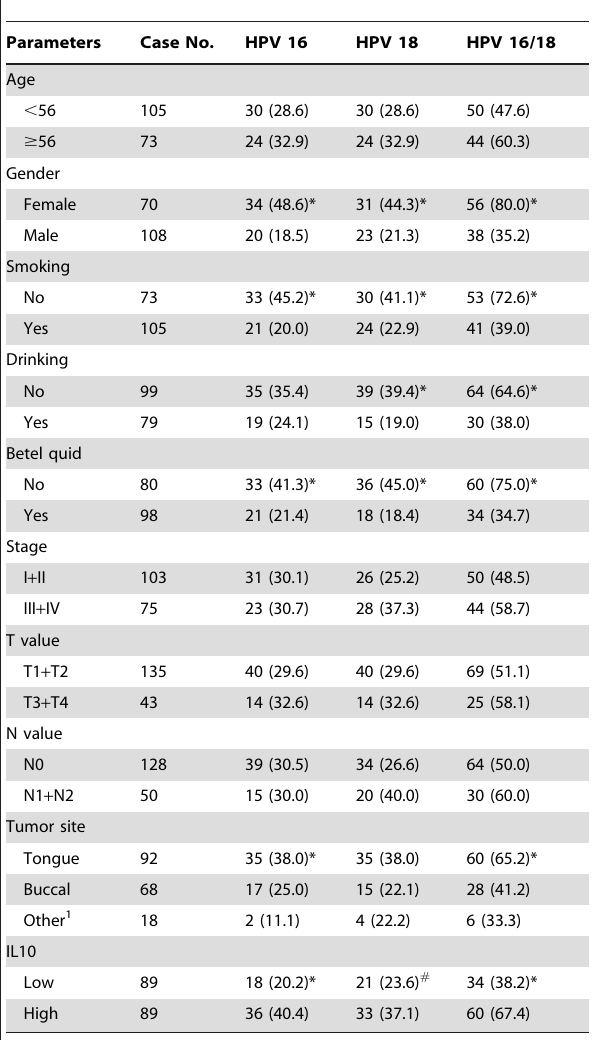
Table 1. Relationships between HPV16, HPV18 and HPV16/18 infection and clinical parameters in OSCC patients.